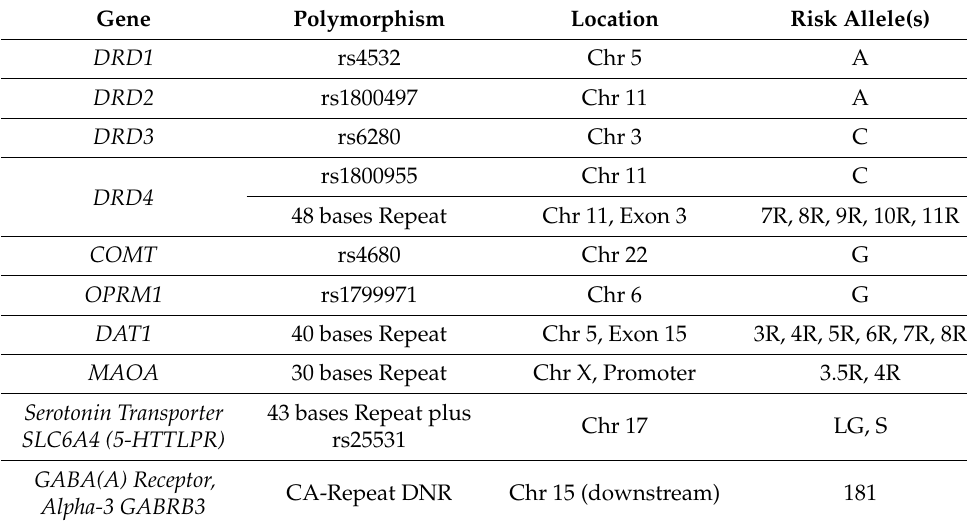
Table 1. Represents the GARS SNPs and VNTRs